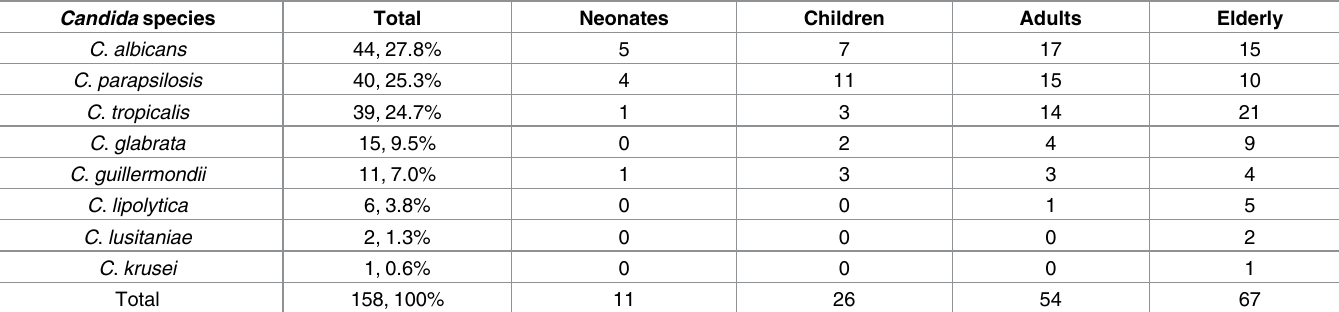
Table 1. Distribution of Candida species by frequency and age group.